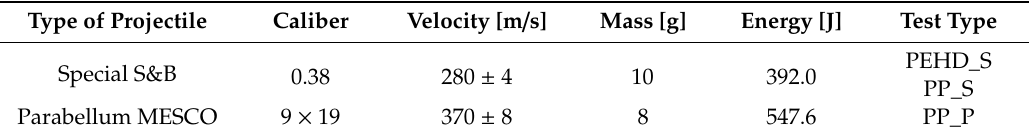
Table 2. Parameters of the ballistic